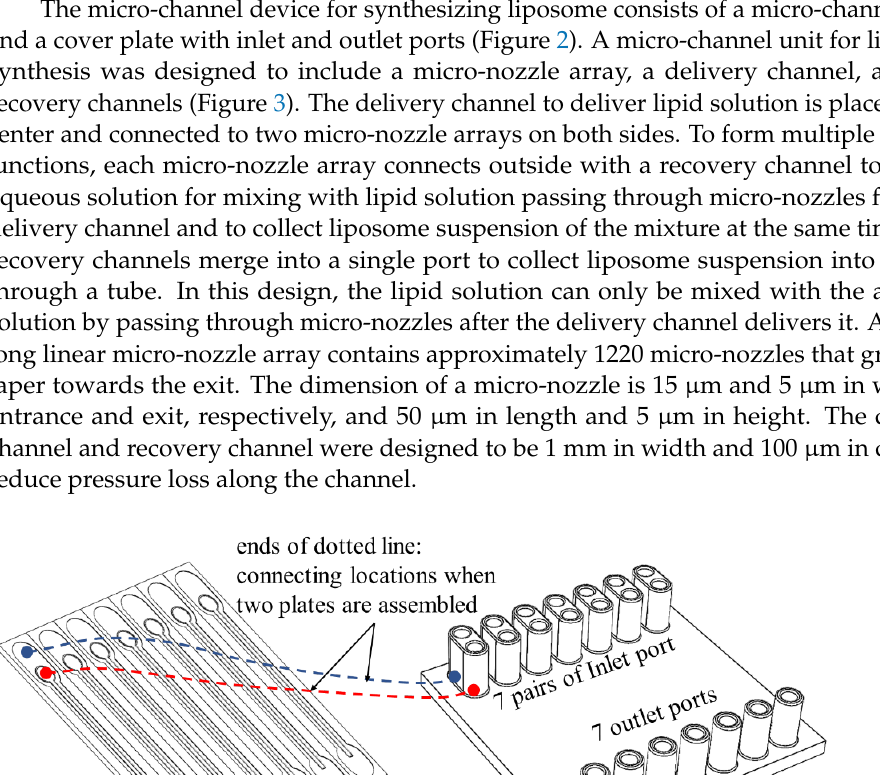
Figure 3. Schematics and design for a unit liposome-synthesizing micro-channel. As shown in Figure 2, seven liposome synthesizing micro-channel units were applied to a micro-channel plate, which is 50 mm × 50 mm in size and 2 mm in thickness. The cover plate has seven pairs of ports connecting to delivery channel and recovery channel. Each pair of ports consists of two inlet ports for supplying lipid solution and aqueous solution each, and one outlet port for collecting liposome suspension. 2.2. Fabrication of the Plastic Device First, two parts of the liposome-synthesizing device, a micro-channel plate, and a cover plate, as shown in Figure 2, were injection-molded using thermoplastic resin or ma- chined mechanically on plastic plate; details on the stamper fabrication process, injection molding conditions, mechanical machining by milling and drilling, and plastic materials used for the parts are explained in Sections 2.3 and 2.4. Two plates were assembled tightly using a holder to seal the micro-channels on the micro-channel plate with the cover plate (Figure 4). The micro-channel plate was injection-molded using a nickel stamper, fabri- cated as explained in the following section because the micro-nozzles cannot be machined